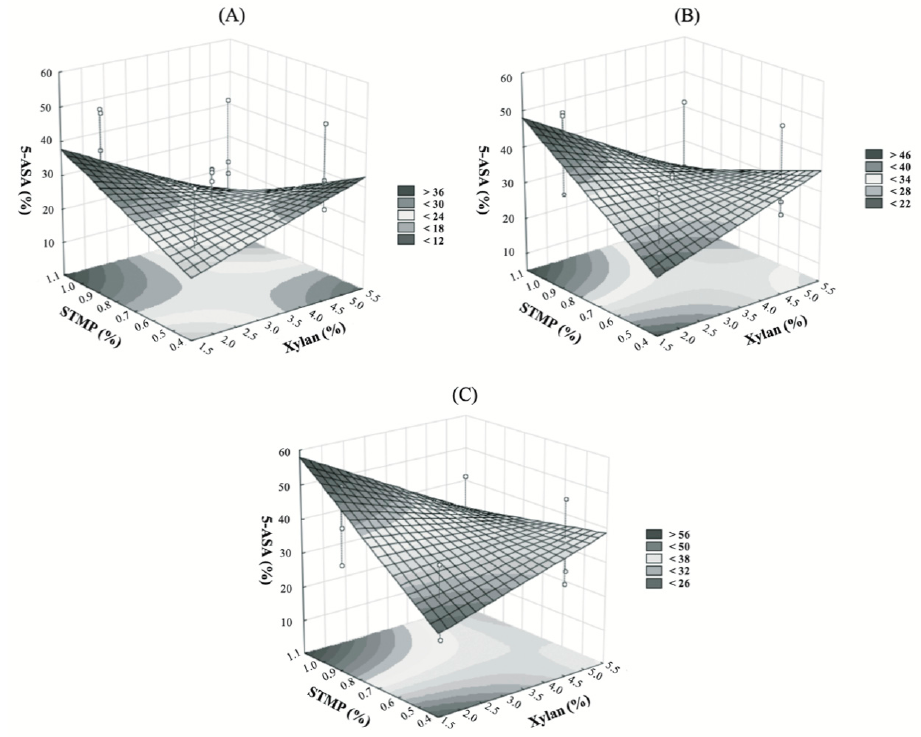
Figure 5. Response surface plot. Correlation of the encapsulation of 5-ASA with xylan-STMP and CaCl 2 concentrations into the formulation. The STMP and xylan concentration were maintained (x-axis), while the concentration of CaCl 2 was increased. In ( A ) it was used 0.5% (w/v) of CaCl 2 , in ( B ) 1.25% (w/v) and in (C) 2% (w/v) .